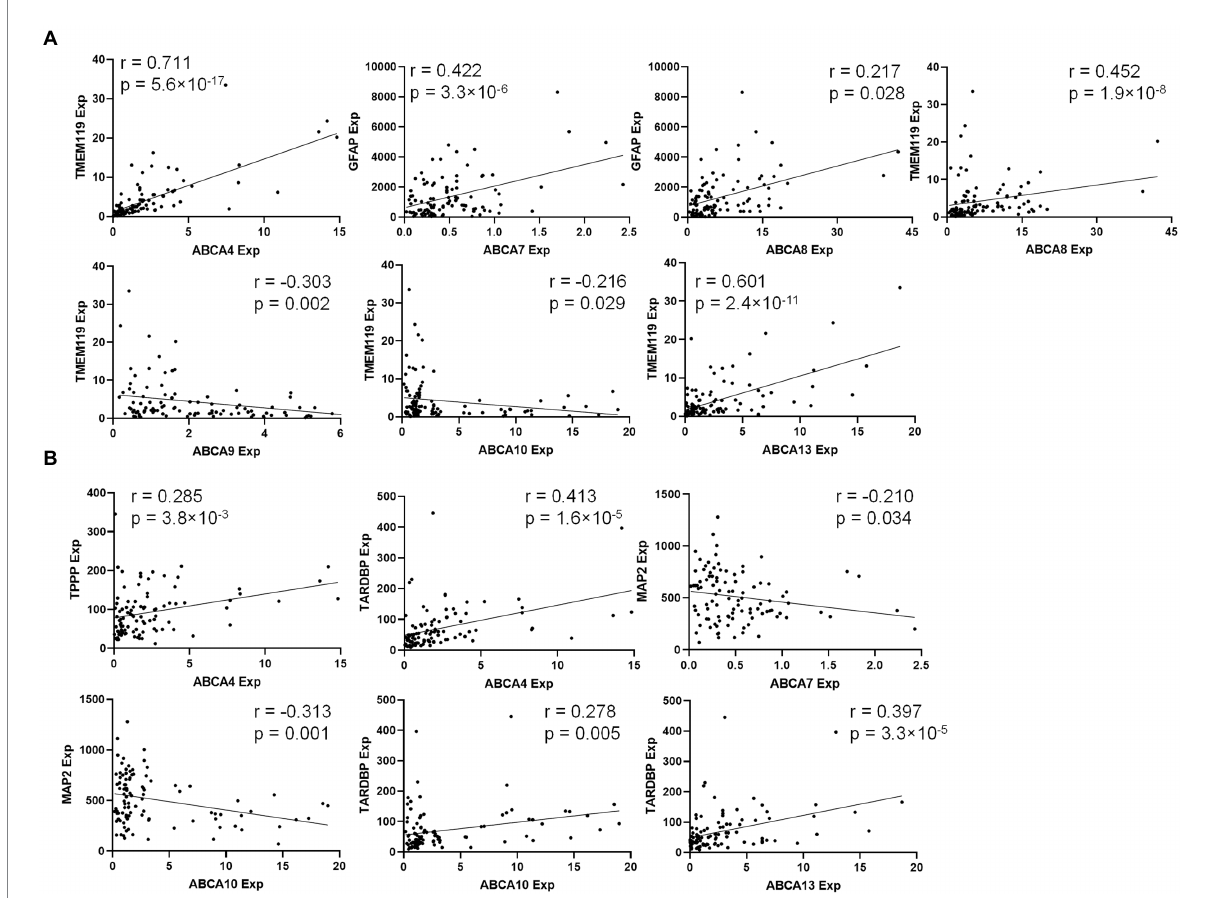
FIGURE 4 Correlation analysis of ABCA transporters with immune related neural markers and TARDBP. (A) A significant correlation between ABCA transporter expression and immune neural markers. (B) A significant correlation between ABCA transporter expression and non-immune neural